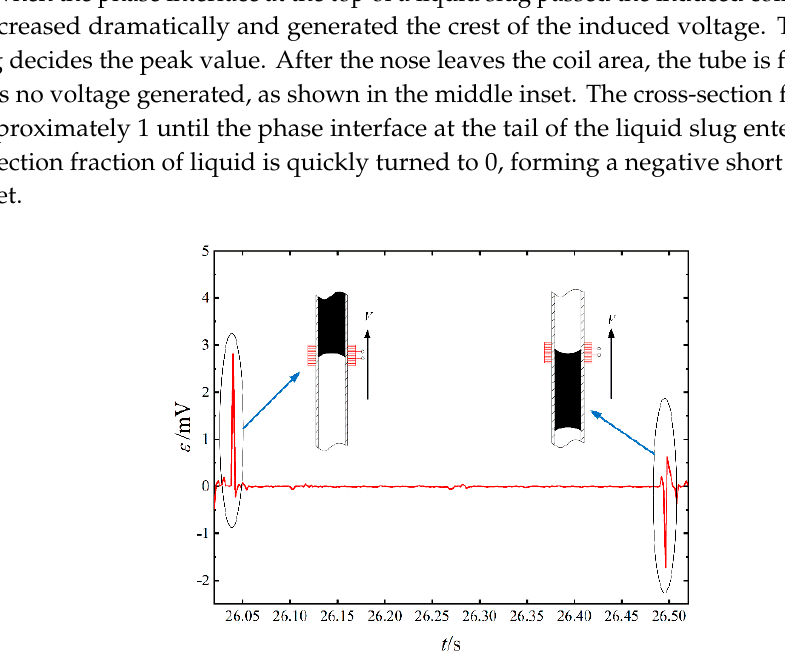
Figure 9. Variation of induced electromotive force with the fluid velocity of working fluid under different inner radii of the PHP.